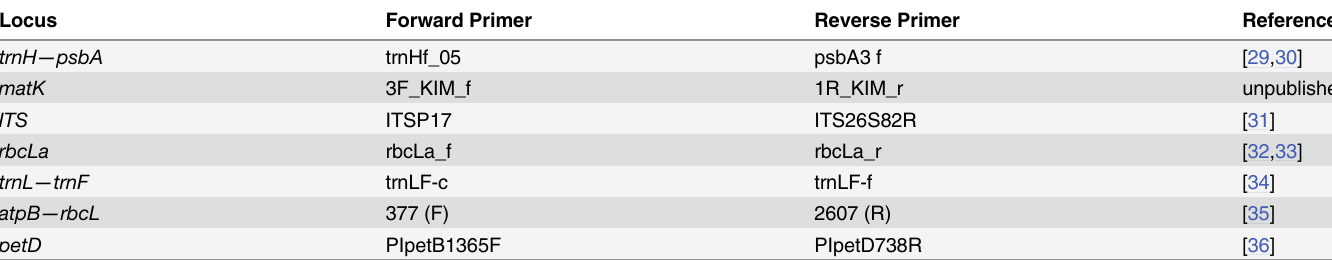
Table 1. List of primers used for each locus with references.